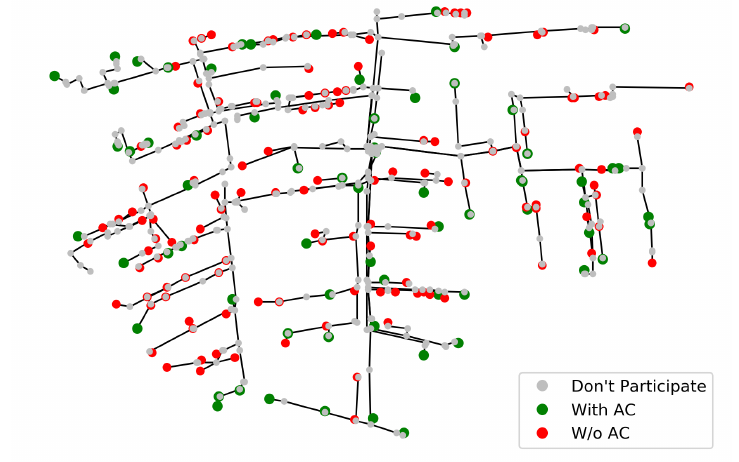
Figure 4. Spanish LV network considered in this paper: each bus is a